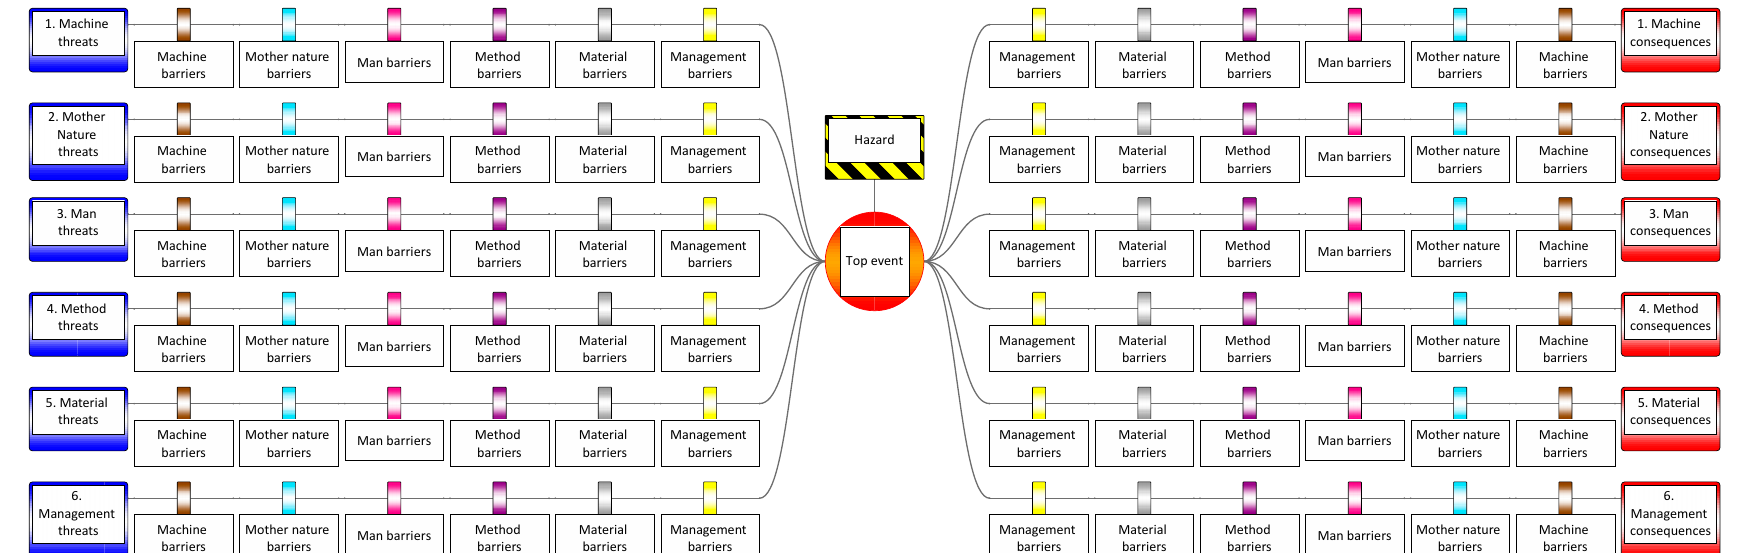
Figure A1. Full Bowtie structure with a 6M × 6M matrix on both sides of the diagram.